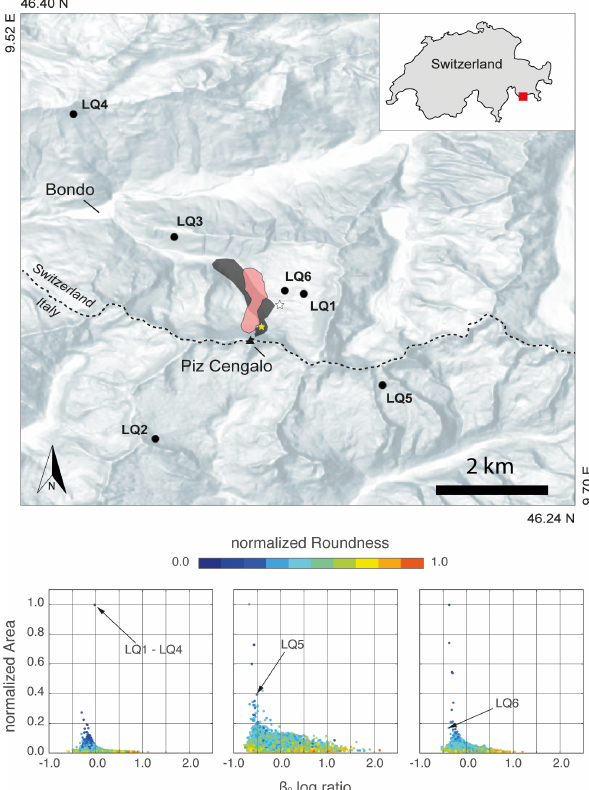
Figure 4. The top panel shows the results of the change detection analysis. The red polygon shows the area identified as potential landquake location for the main landquake event (i.e., LQ1–LQ4) identified by processing the Sentinel-1 pre- and post-event, while the gray polygon is the area hit by the rock avalanche (compare Walter et al., 2019). The white star and the yellow star show the locations of the largest segments for LQ5 and LQ6, respectively, as identified within the Bondasca valley. Also see the Supplement for more details on the segmentation results. The black dots show the epicentral locations provided by SED (see Table 1). The bot- tom plot shows scatterplots indicating the distribution of changes in radar backscatter versus normalized areas of the segments. The color map shows the normalized roundness. The segments associ- ated to the landquakes are identified by the black arrows. See the text for more